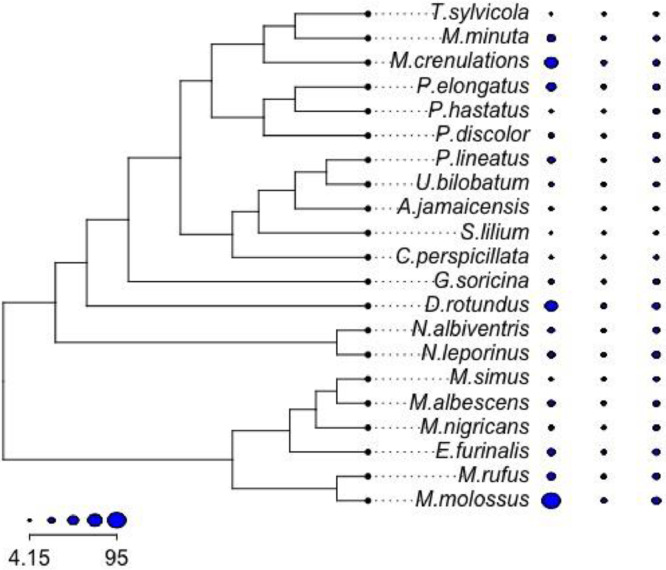
The phylogeny of bats included in ouxy. The trait is shown using blue circles using different sizes. Traits from the left to the right are the response: body mass (g), and two covariates: head height (mm) and head length (mm). Species names are shown in the middle of the plot.